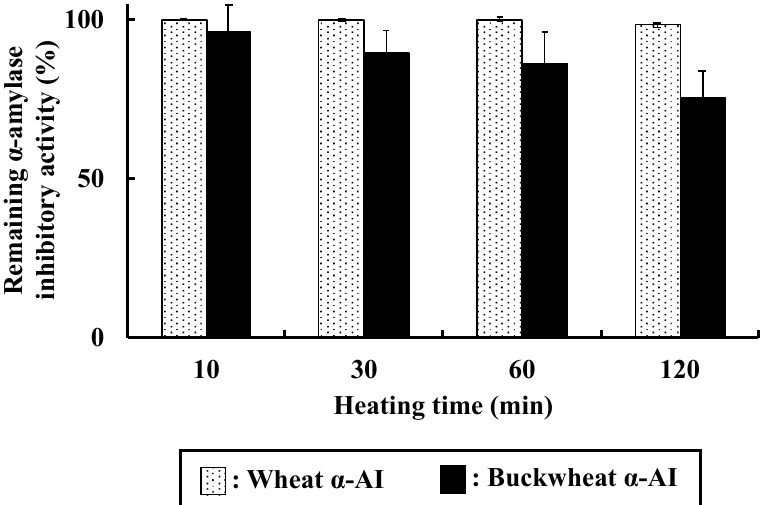
Figure 9. Thermal stability of wheat and buckwheat α -AIs. Each value is the mean of 2–3 experiments with S.E. shown as a vertical bar.